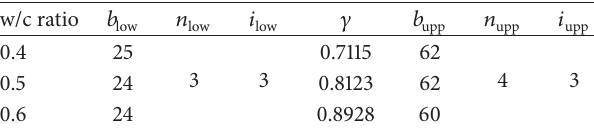
Table 2: Parameters of the solid mass fractal model.